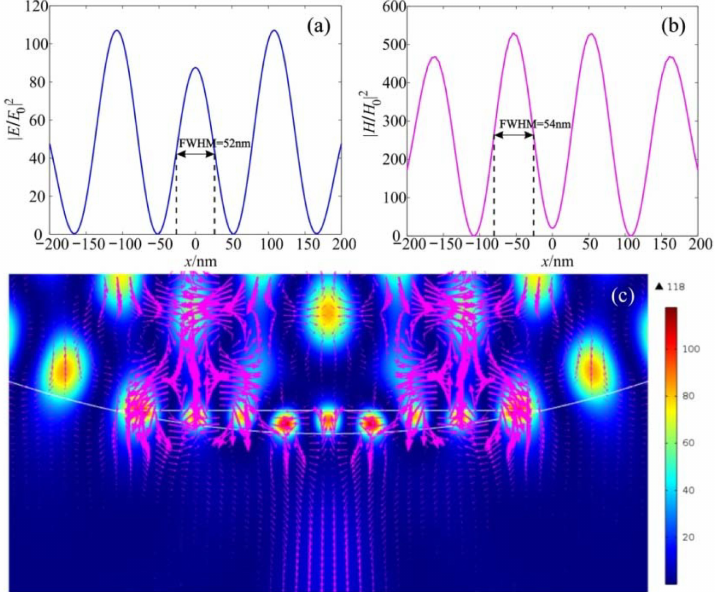
Figure 7. Field intensity distribution along the extreme hot spots for the ( a ) electric and ( b ) magnetic components; ( c ) Poynting vector energy